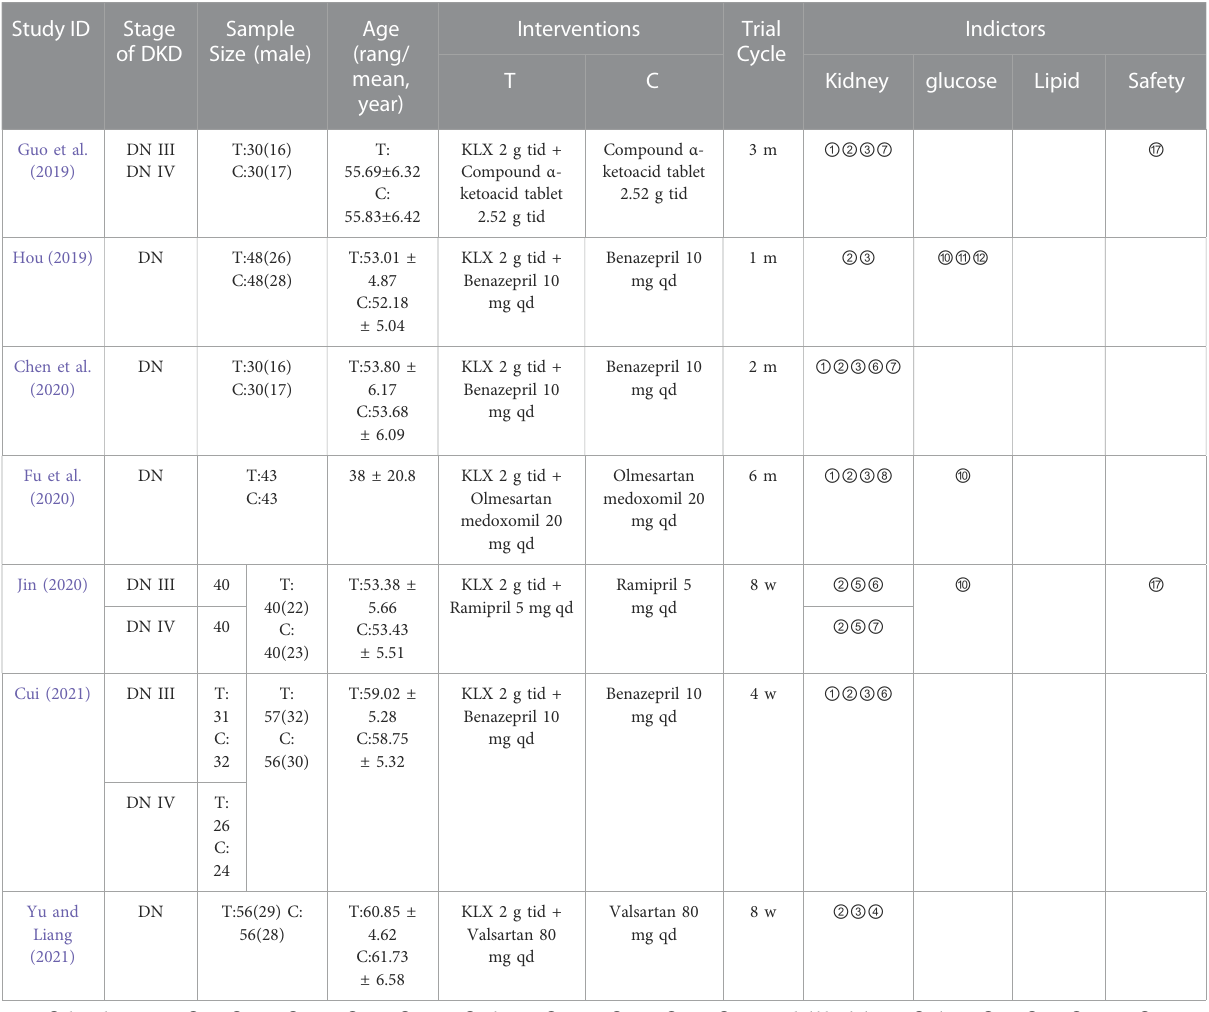
numerical table method, double-blinding,